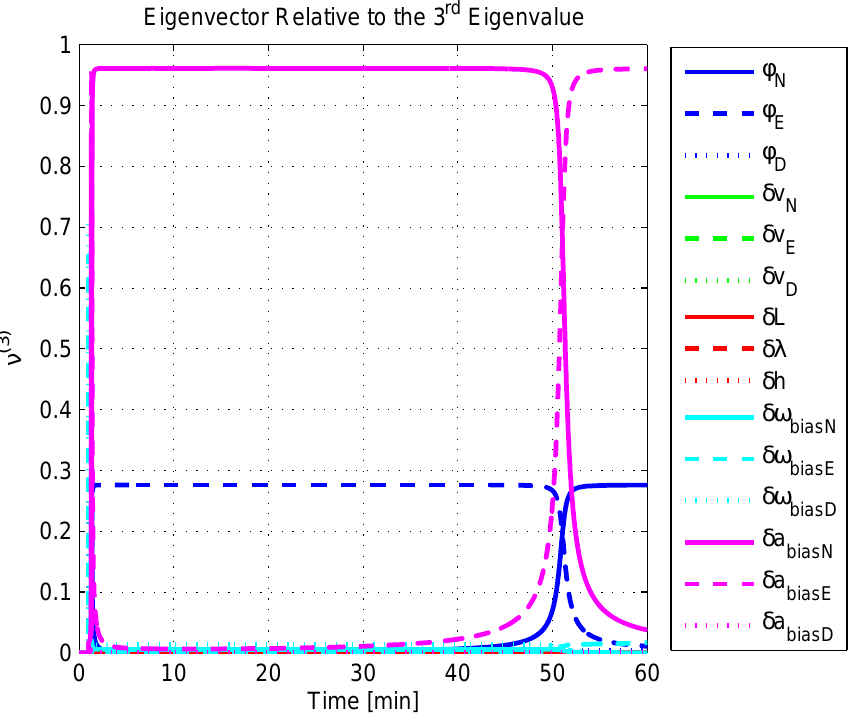
Figure 10. Eigenvector relative to the third eigenvalue in the simulated test.